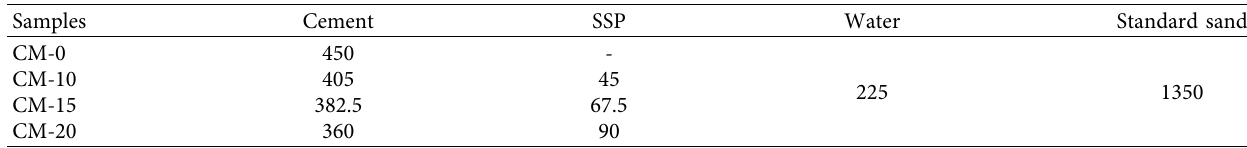
Table 3: Mix proportions of cement mortar (g).